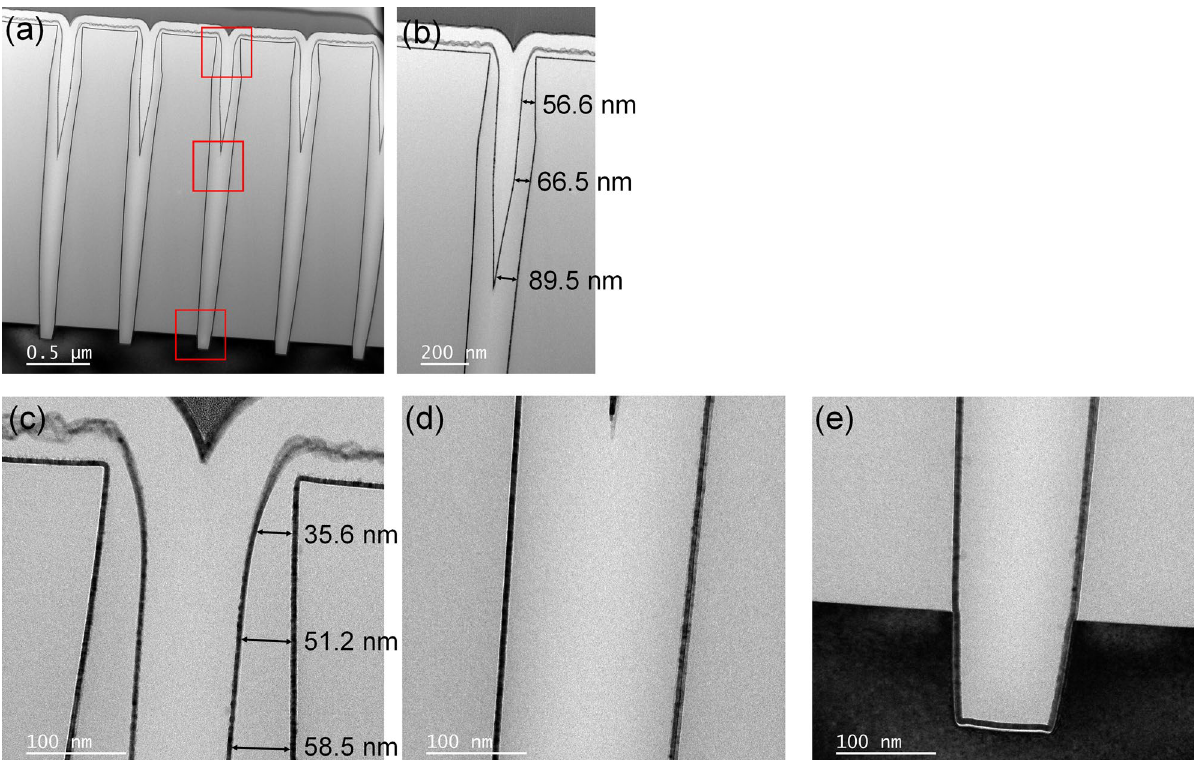
Figure 10. ( a ) Cross-sectional TEM image of the trench patterns (opening and depth of 200 nm and 2.5 μm, respectively) after conducting the SiO 2 PE-ALD using NH 3 * . ( b ) 20,000× magnified image of trench opening area, and ( c – e ) 80,000× magnified images of ( c ) trench opening area, ( d ) center of trench, and ( e ) bottom of trench (depicted as red boxes in ( a )), respectively.